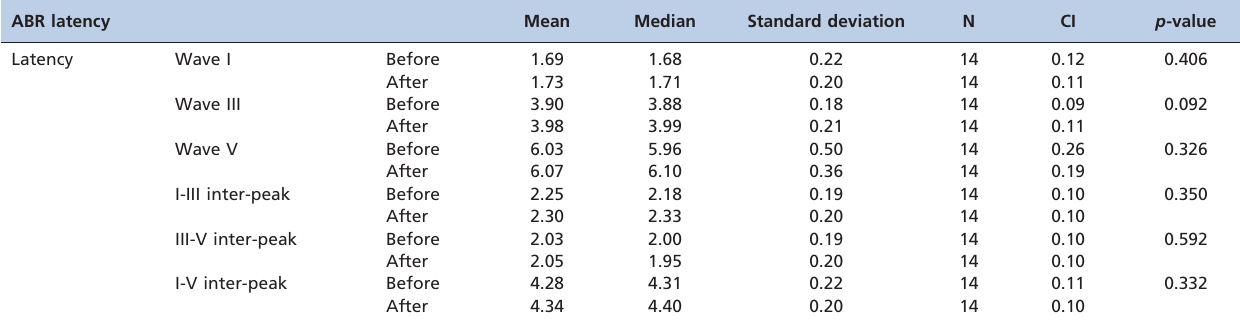
Table 1 - Absolute latency (ms) of waves I, III and V and the inter-peak intervals of ABR before and after auditory